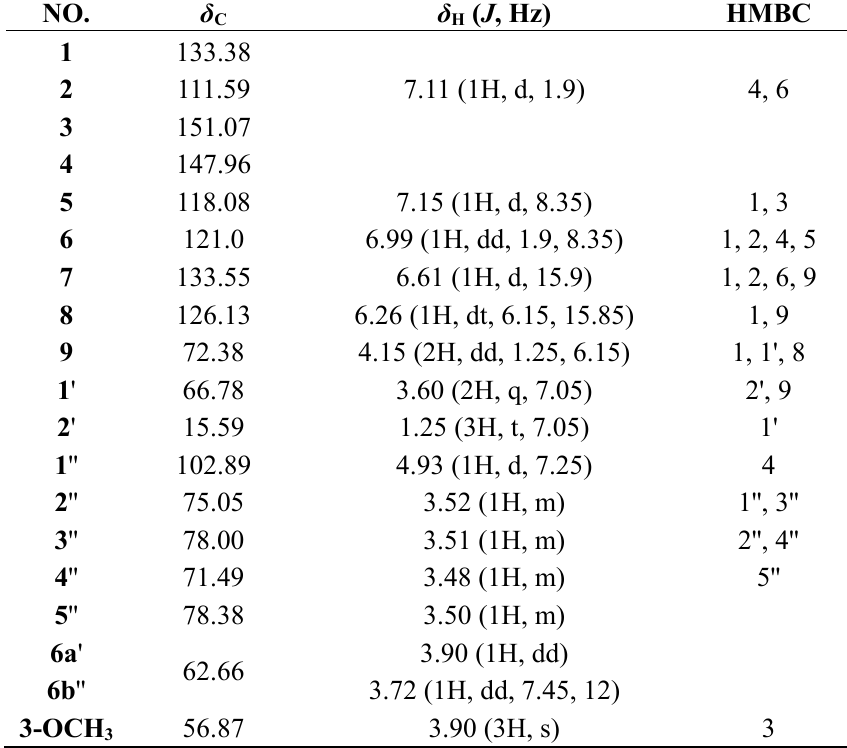
Table 1. 1 H-NMR (500 MHz) and 13 C-NMR (125 MHz) spectral data and HMBC Correlations of Compound 1 in CD 3